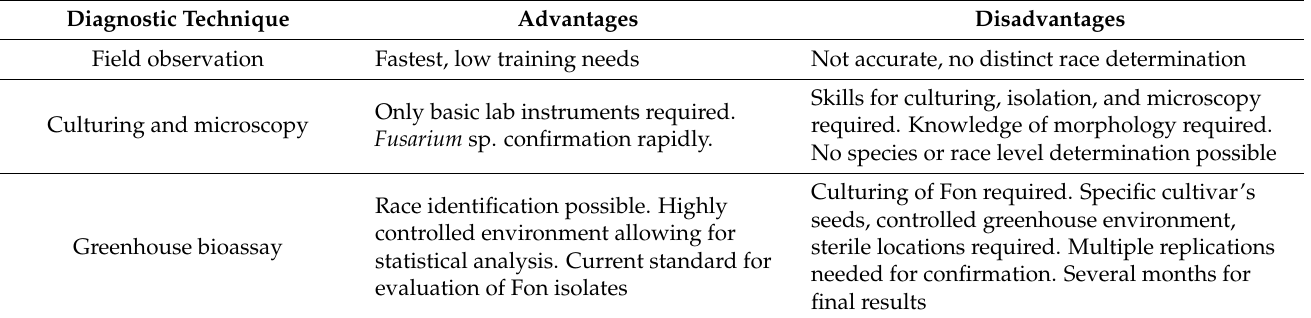
Table 3. Comparison between diagnostic techniques available for Fusarium wilt of